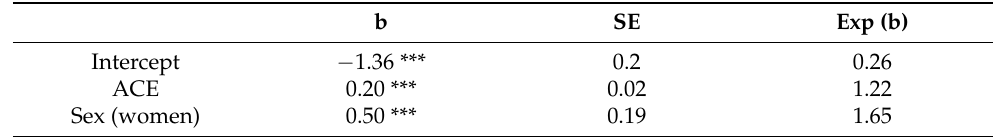
Table 7. Poisson model for the mental health